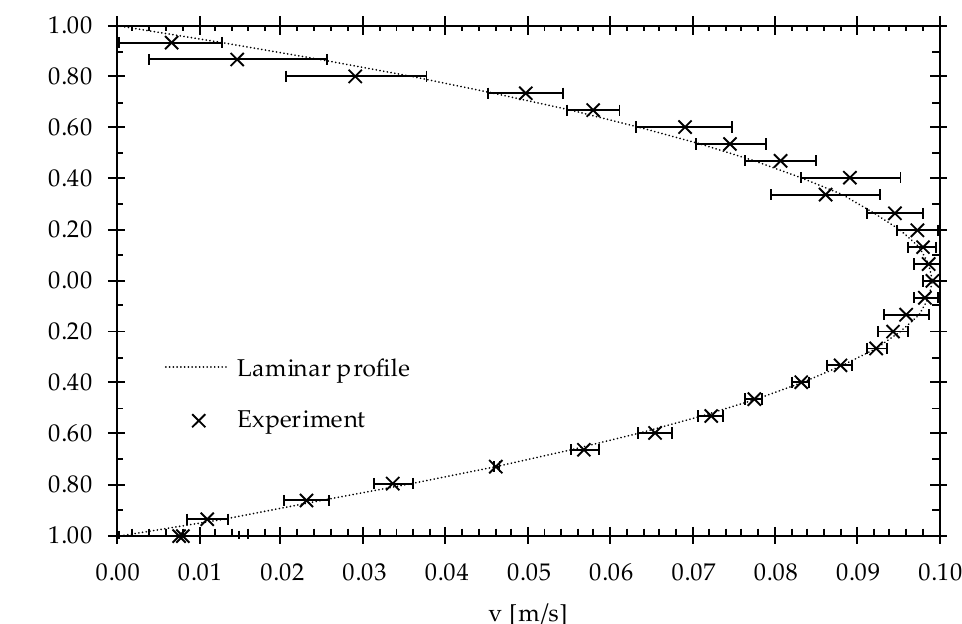
measurement procedure 29 times. Figure 6 shows the velocity profile from the averaged experimental results compared with the benchmark laminar flow for Re = 2137.